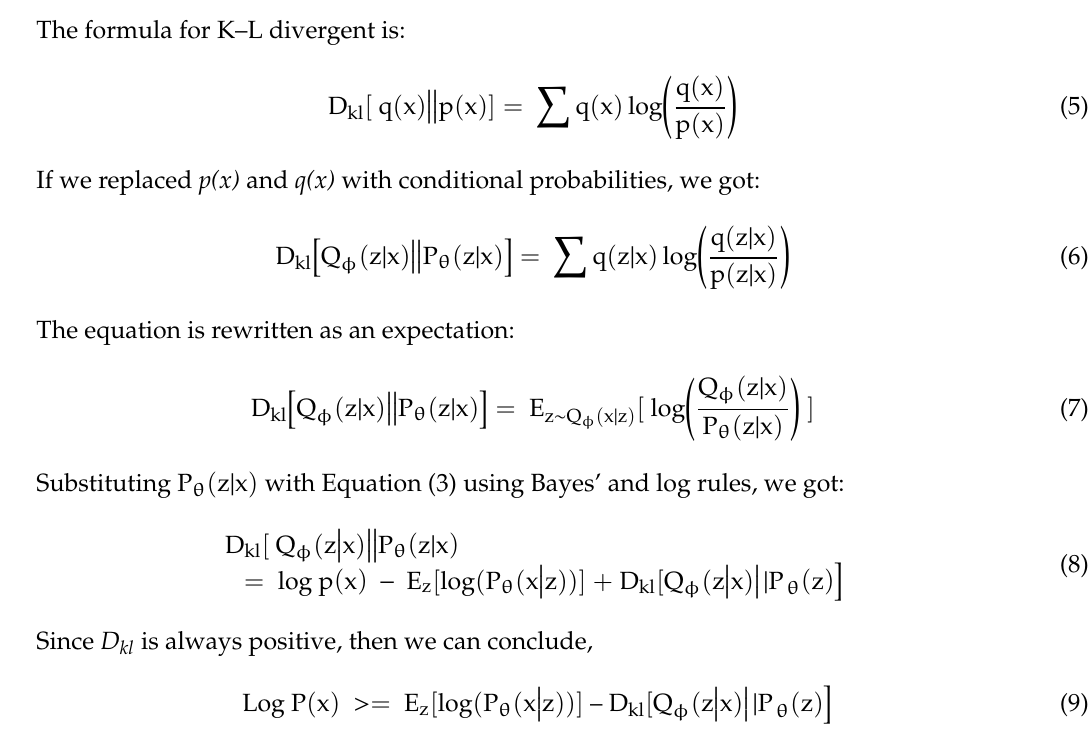
Figure 5. Approximating p given q .